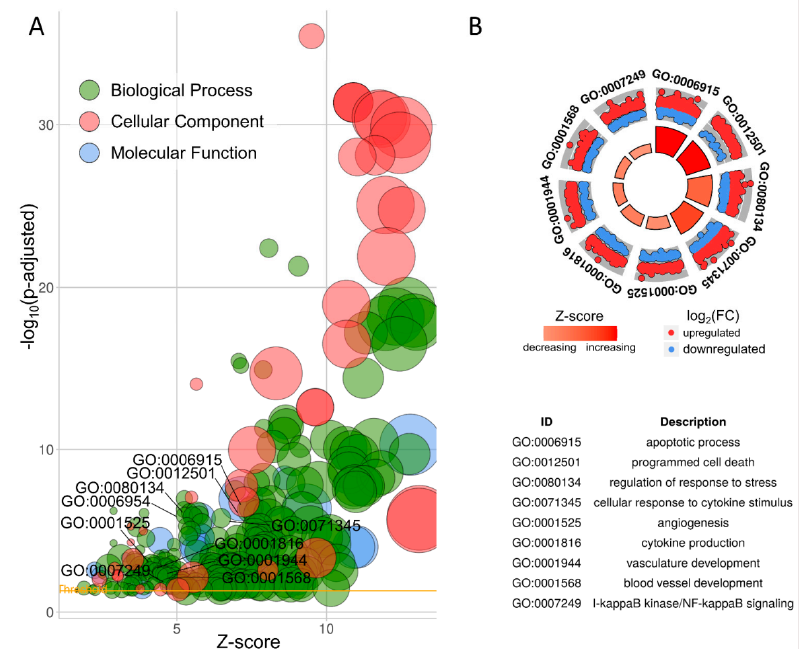
Figure 3. Enrichment ontology visualization. ( A ) GOBubble chart of the ontology terms (biological process—BP, cellular components—CC and metabolic function—MF) detected during Gene Ontology (GO). Circle size is proportional to the logarithmic scale of adjusted p -value in enrichment GO analysis. Z-score is calculated from the number of up- and downregulated genes enriched in each GO term. ( B ) Circos visualization of 10 selected BP processes related to DVT. Red dots illustrate upregulated differentially expressed genes (DEGs); blue dots represent downregulated DEGs; black dots are not significant transcripts.